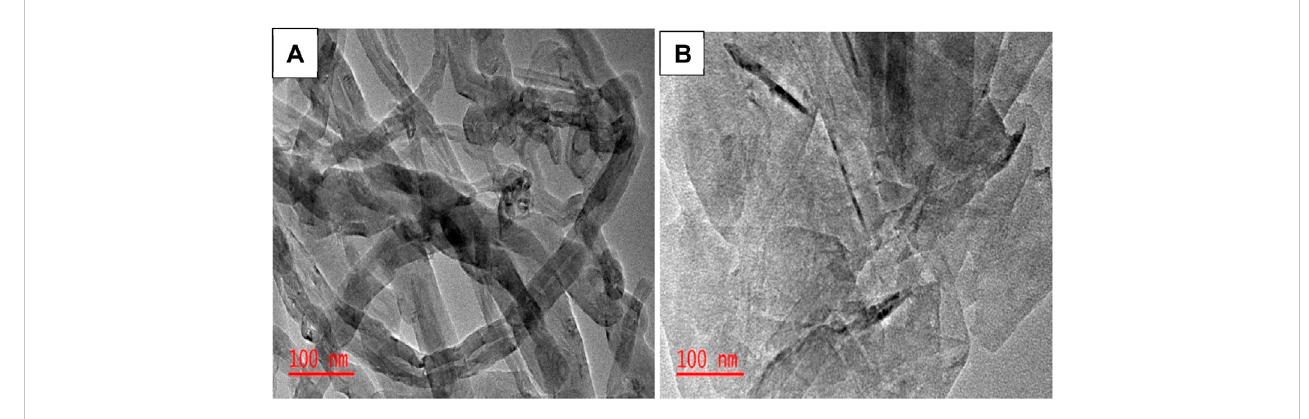
TEM micrographs of the (A) CNTs and (B) BN